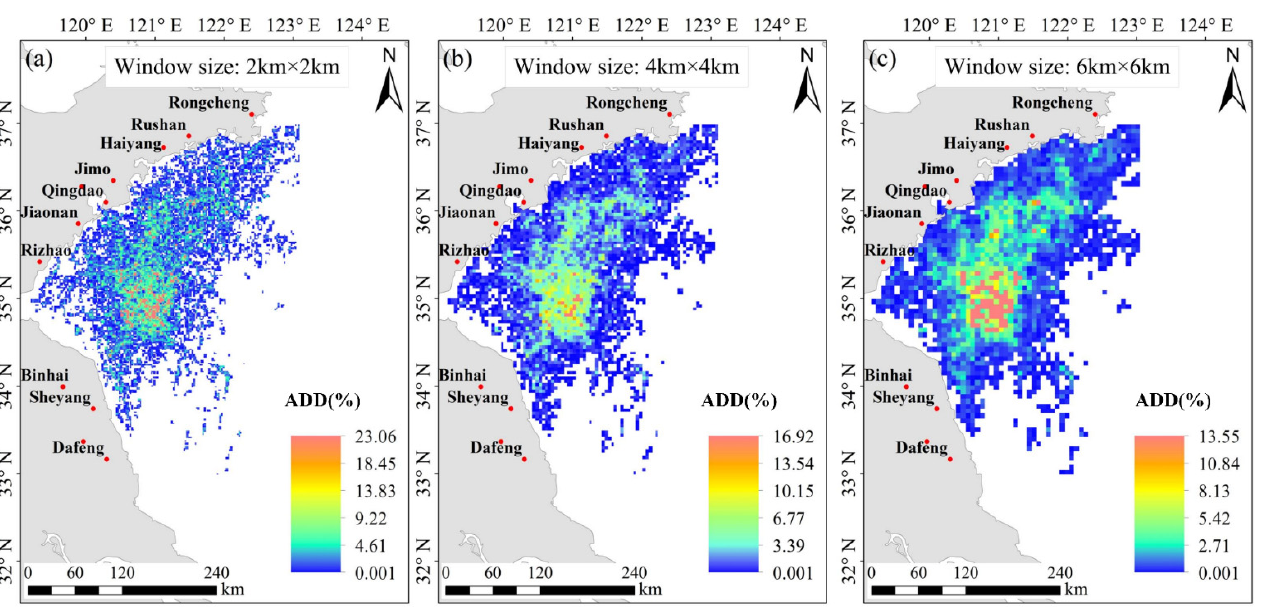
Figure 5. Comparison of annual distribution density (ADD) of macroalgae blooms based on different window size.